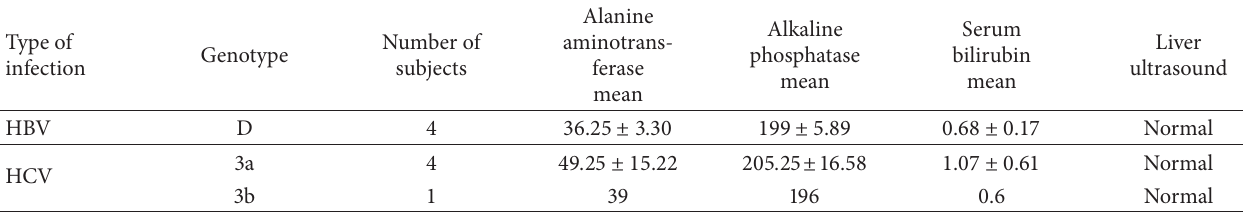
Table 2: Blood biochemistry and liver ultrasound for different infection